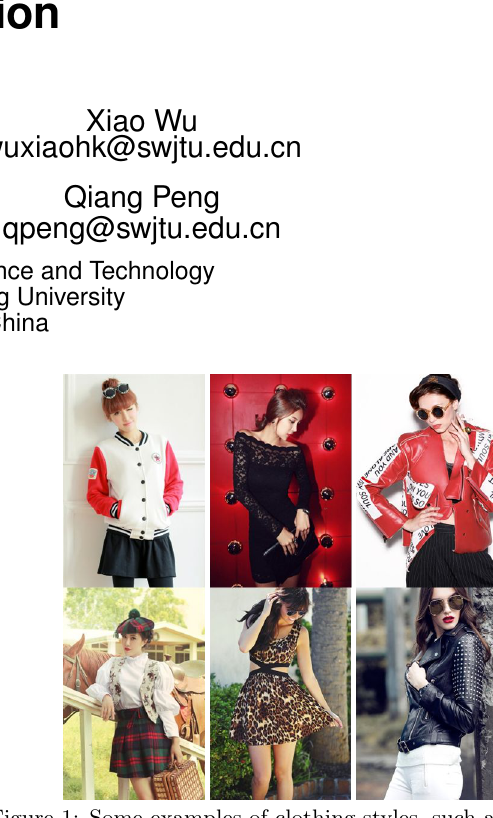
Figure 1: Some examples of clothing styles, such as British, Sexy and